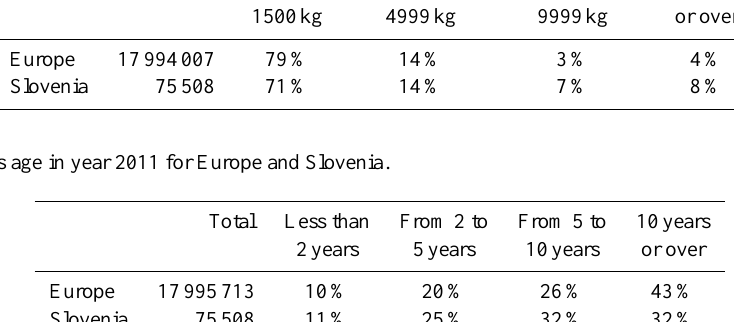
Table 5. Statistics on lorries weight in 2011 for Europe and Slovenia. Total Less than From 1500 to